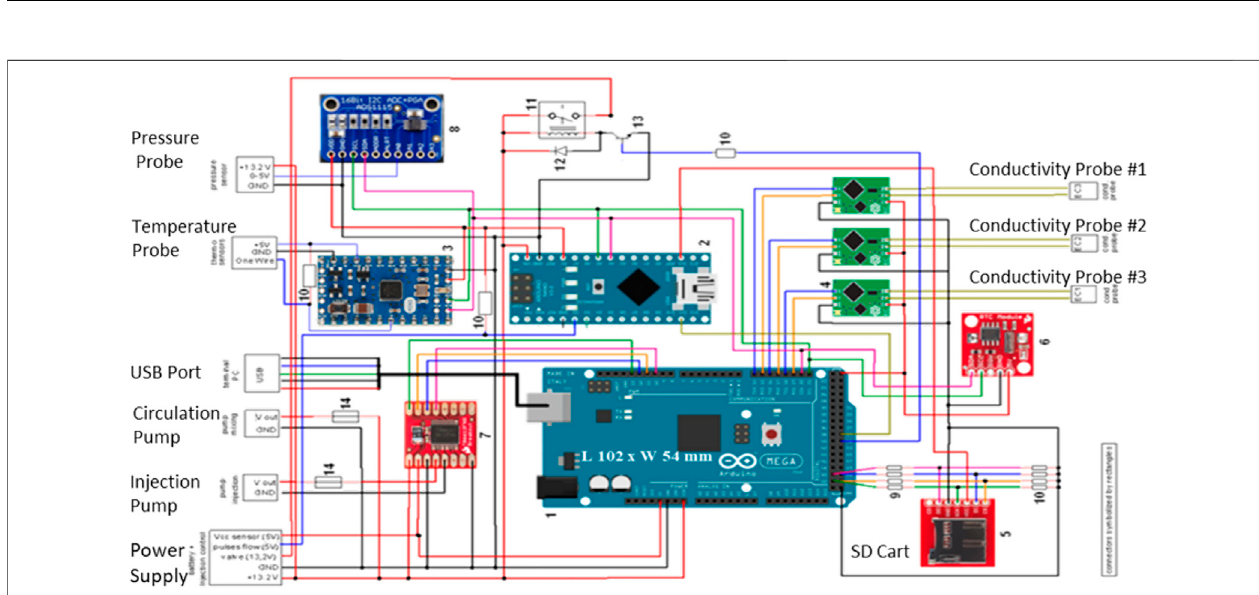
FIGURE5 | Wiringdiagram and electronic components of theSGD-MRT. The list ofelectronic componentsand the Arduino shields ispart of the Supplementary Material .